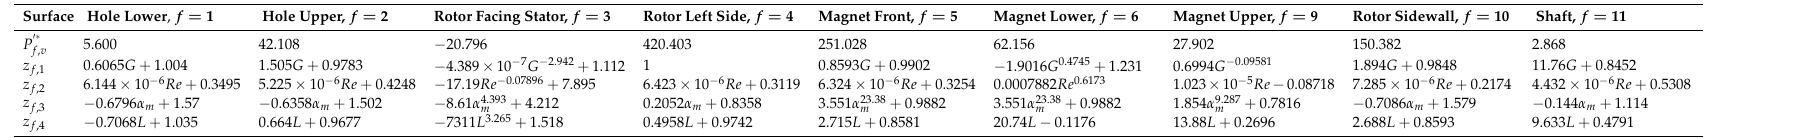
Table 1. Correlations to estimate the windage losses (W) due to viscous forces.